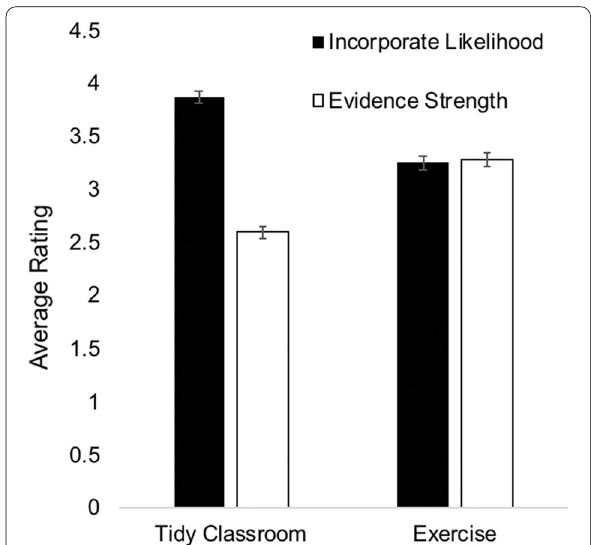
Fig. 1 Means of ratings for evidence strength and incorporate likelihood as a function of intervention type (tidy classroom/exercise) for Experiment 1. Error bars represent within-subjects standard error of the mean (Cousineau, 2005)